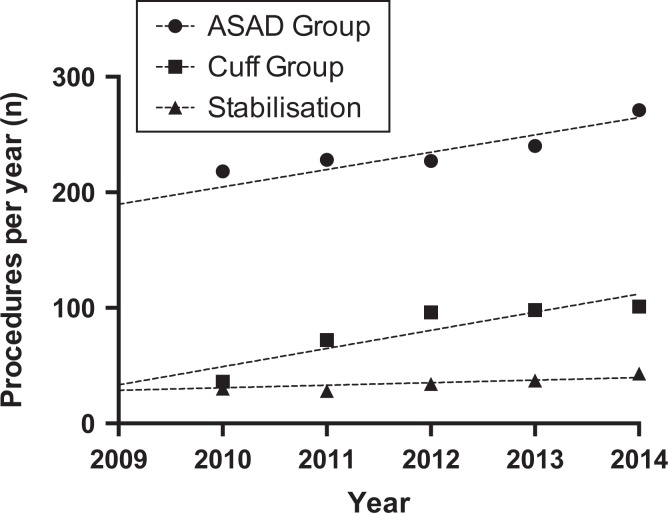
Number of other index shoulder arthroscopic procedures performed per year (lines represent linear regression).